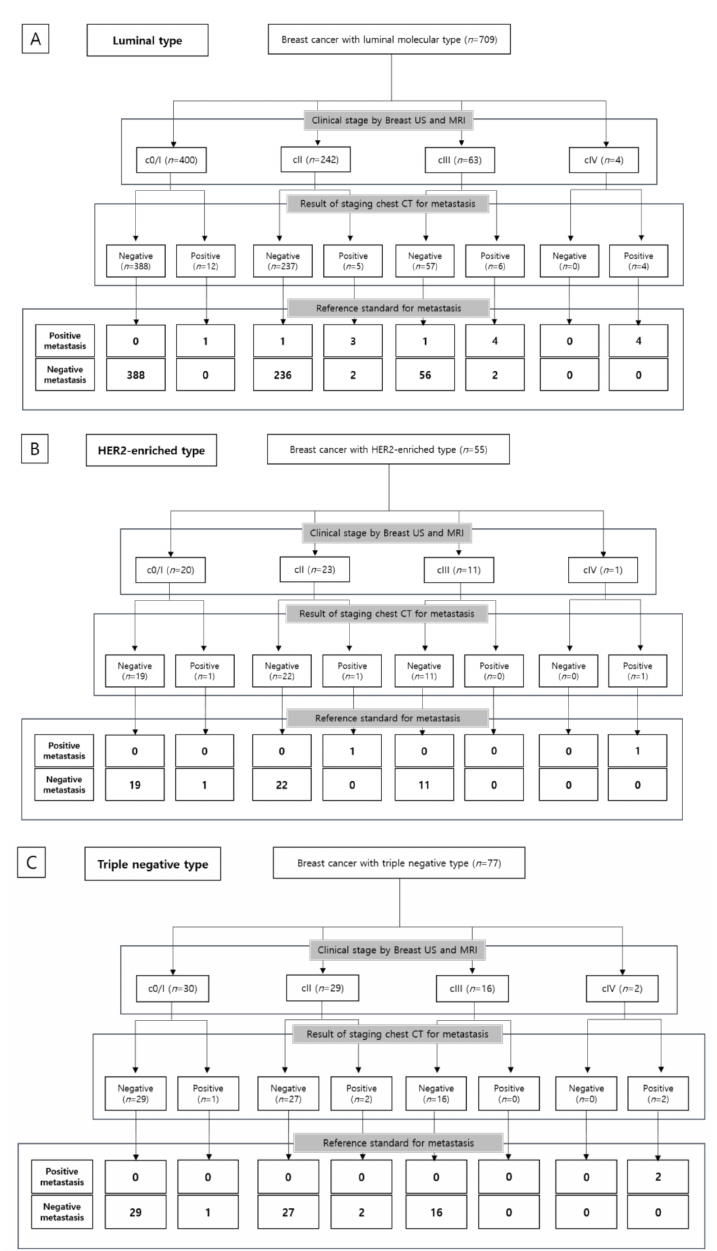
Figure 3. Patient flow diagram showing reference standard for metastasis based on molecular subtype. ( A ) Luminal type; ( B ) HER2-enriched type; ( C ) Triple-negative